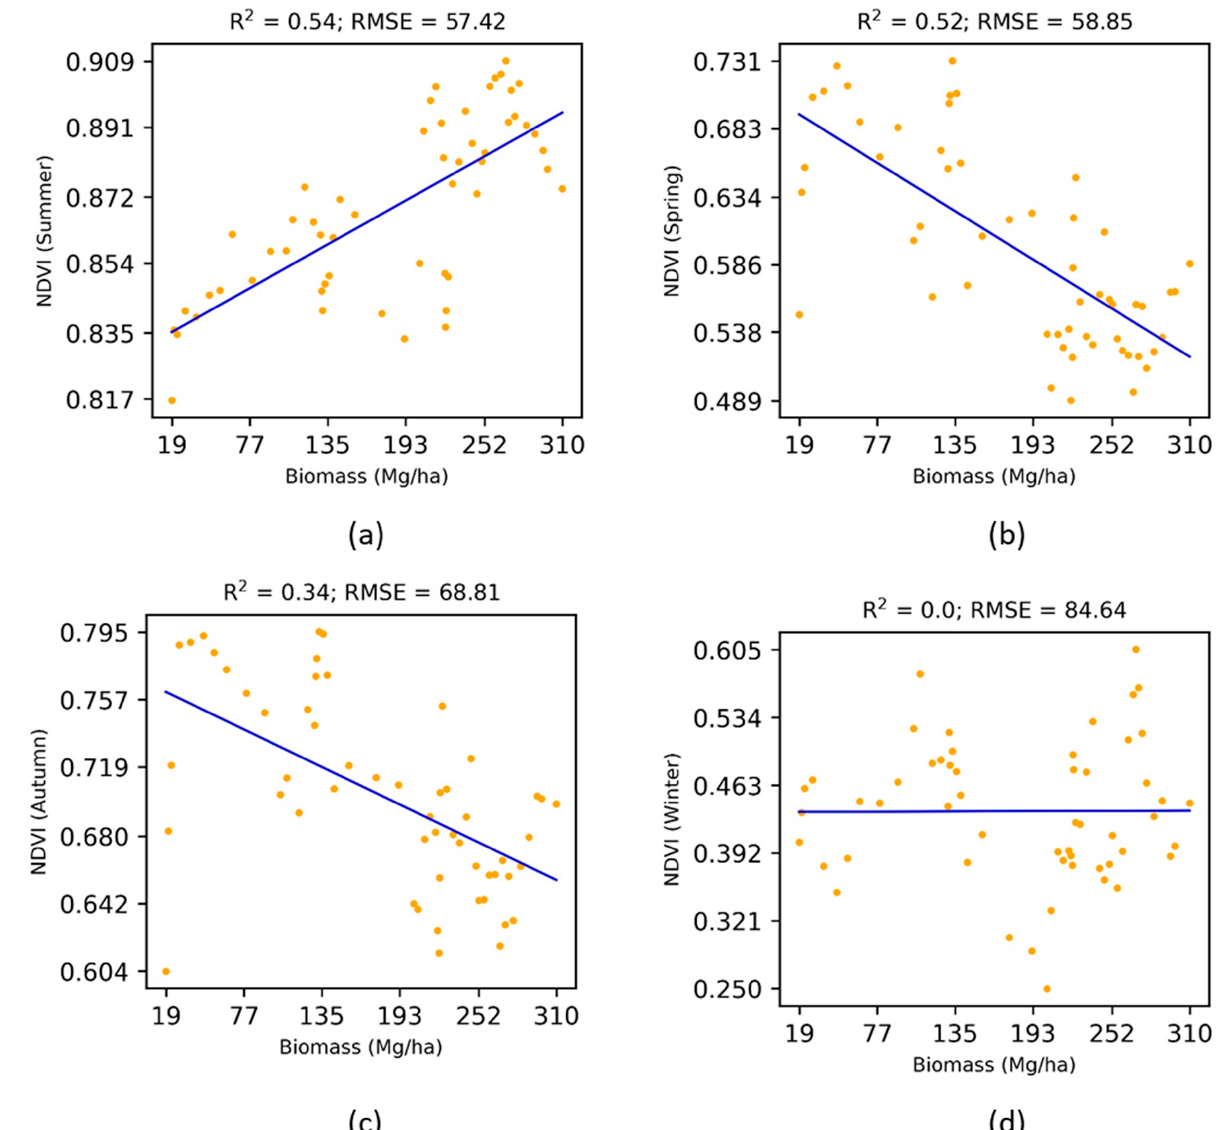
Figure 8. Effects of seasonal NDVI (iso) on the above-ground biomass.